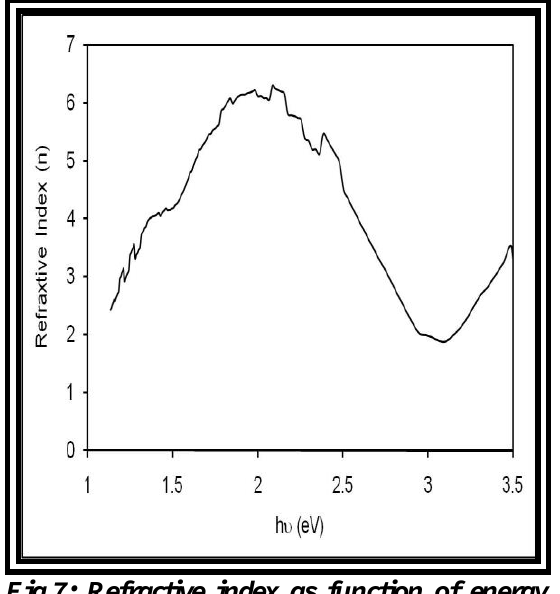
Fig.7: Refractive index as function of energy photon of copper oxide thin film.